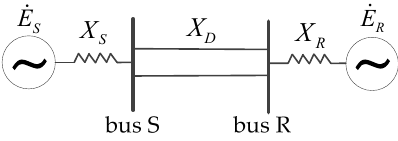
Figure 2. Equivalent model of the system.